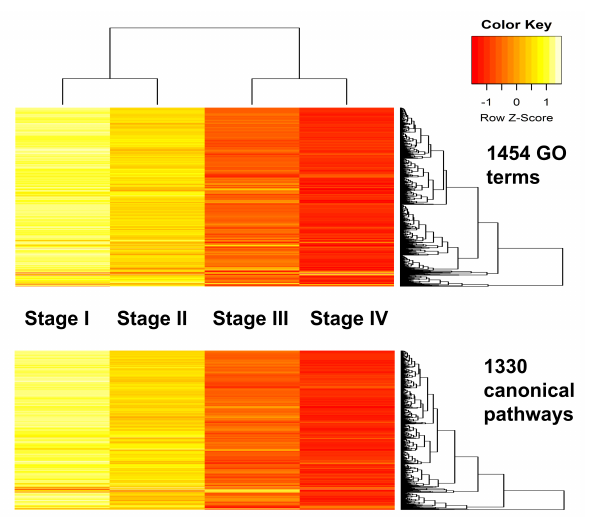
Figure 3. Heatmaps and dendrogram for the stage I–IV groups. The dendrogram (top of the heatmap) show the relationship between the four stage groups. When displayed on the heatmaps, the GSR indices of the four stages computed through either the GO terms or canonical pathway gene sets showed distinct patterns and stepwise deteriorations in the functions from stage I to IV.